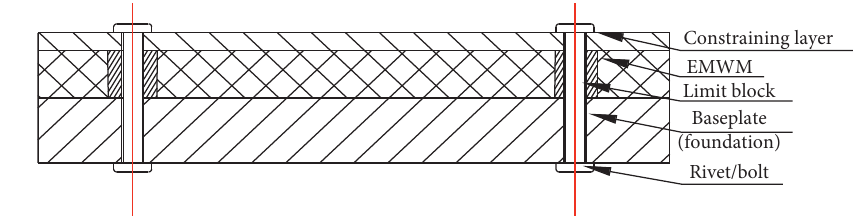
Figure 4: Composite structure with EMWM layer.